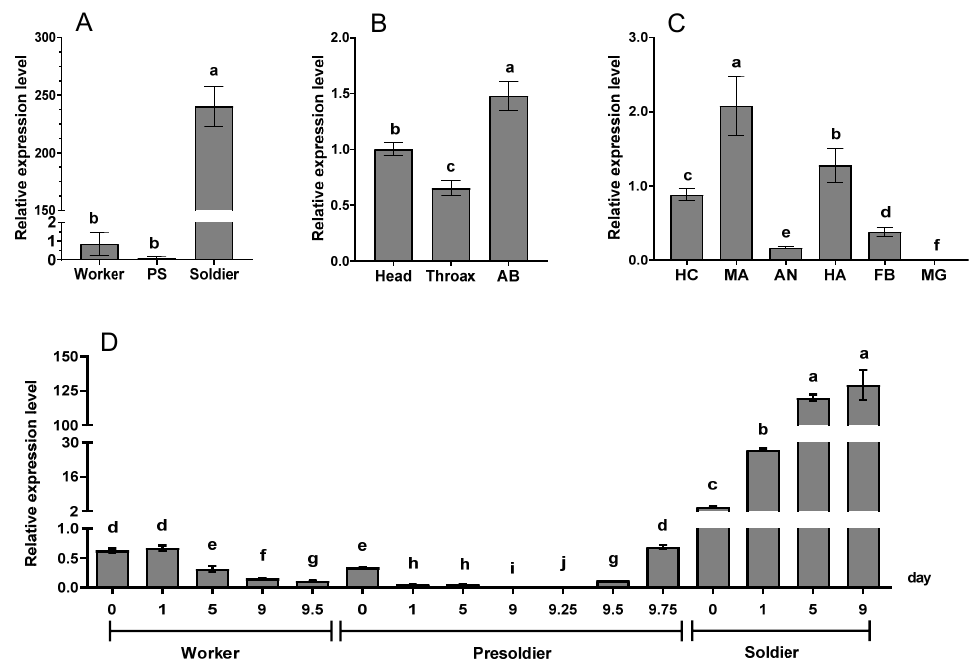
Figure 2. RaSsp1 expression patterns of R. aculabialis in nature colonies and induced soldier differ- entiation. ( A ) RaSsp1 expression levels of the head of workers, presoldiers and soldiers in nature colonies. ( B ) Expression levels of RaSsp1 in soldier different part. ( C ) Expression levels of RaSsp1 in soldier tissues of nature colonies. PS: presoldier; AB: abdomen; HC: head cuticle; MA: mandible; AN: antennae; HA: hemolymph; FB: fat body; MG: midgut. ( D ) The RaSsp1 expression patterns in the heads of R. aculabialis during soldier differentiation with JHA induction. Workers: 0, 1, 5, 9, and 9.5 days after JHA treatment; presoldier: 0, 1, 5, 9, 9.25, 9.5 and 9.75 days after the 1st molting; soldier: 0, 1, 5, 9 after the 2nd molting; 0 days in presoldiers and soldiers show within 24 h after molting. Different letters above the bars denote significant differences (one-way ANOVA followed by LSD test using SPSS, p < 0.05).